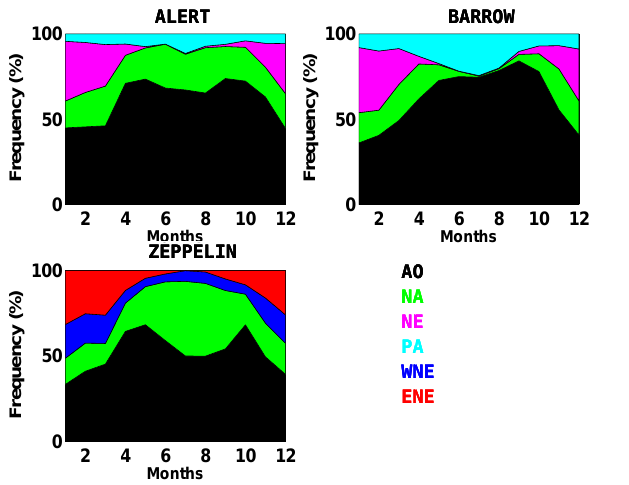
Fig. 10. The frequencies of the transport clusters as function of the month of the year for Alert (upper left), Barrow (upper right), and Zeppelin (bottom left).